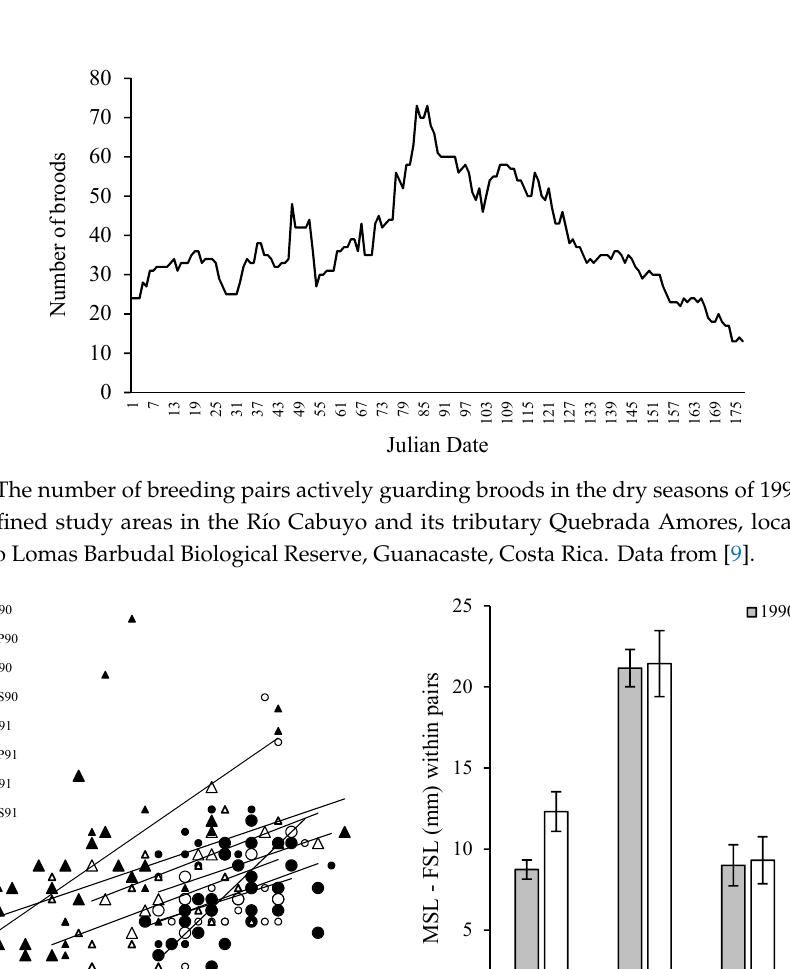
Figure 3. ( a ) Male standard length (mm) versus female standard length in mated pairs of convict cichlids by 1990 and 1991 in the pool (P) and stream (S) habitat in Río Cabuyo and Quebrada Amores. Large males monopolize spawning sites and large females produce larger clutches leading to size-assortative mating. ( b ) Overall mean ± SE length difference within a pair was 13.78 ± 0.59 mm ( n = 149), and intrapair difference differed significantly by site (F 3,145 = 44.25, p < 0.001). Small females were not found spawning in Quebrada Amores as often as they occurred in Río Cabuyo. Data from [10]. The young emerge from the lair at a size of about 4.5–5.0 mm standard length (SL) and remain associated with parental protection until they are about 10 mm SL, which can take 4–6 weeks depending on the growth rate of fry that varies from site to site [10]. After the young become independent and disperse, the pair bond between the adults dissolves and the male may form a pair bond with a new female and spawn again, often reusing the same lair (Figure 4). Males may spawn up to four times within a 5-month dry season whereas most females spawn only once.